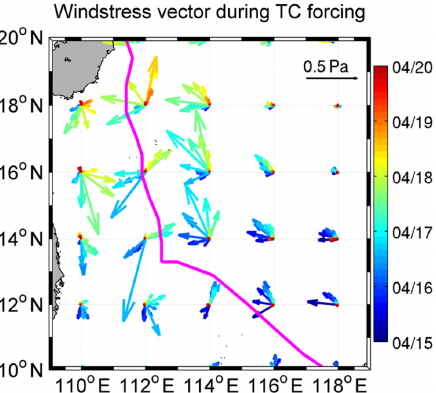
Figure 6. Time series of 6-hourly wind stress vectors during the forced-stage (FS) from 15 to 20